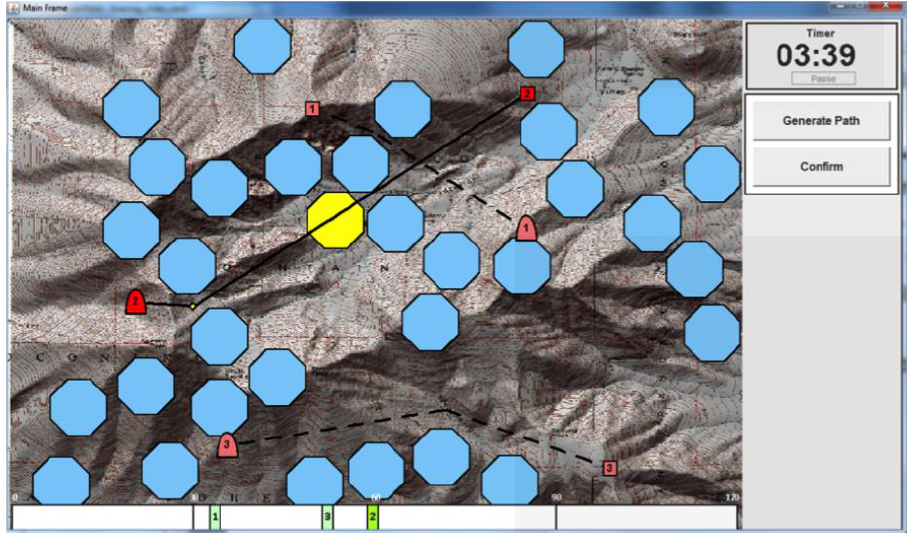
Figure 1 . The view of a UAV simulation from the operator’s perspective [17]. Figure 1. The view of a UAV simulation from the operator’s perspective